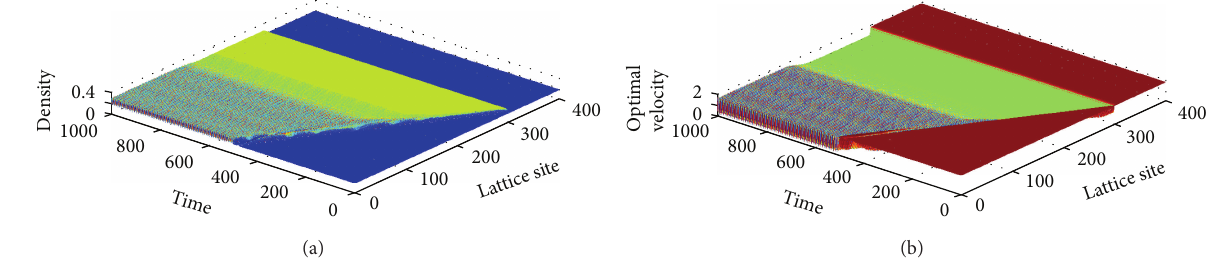
Figure 13: The spatiotemporal evolutions for 𝜌 ℎ = 0.18 , 𝑄 on = 0.18